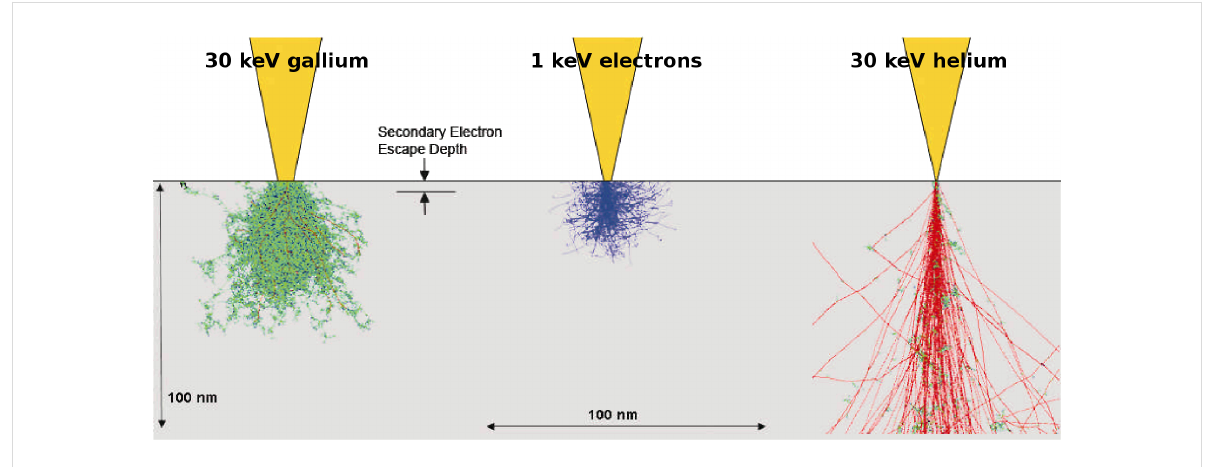
Figure 3: Electron and ion beam substrate penetration – Monte Carlo simulations of charged particle paths showing forward and back scattering. Reproduced with permission through Creative Commons Attribution (CC BY) from [30], 2007 AIP Conference Series.